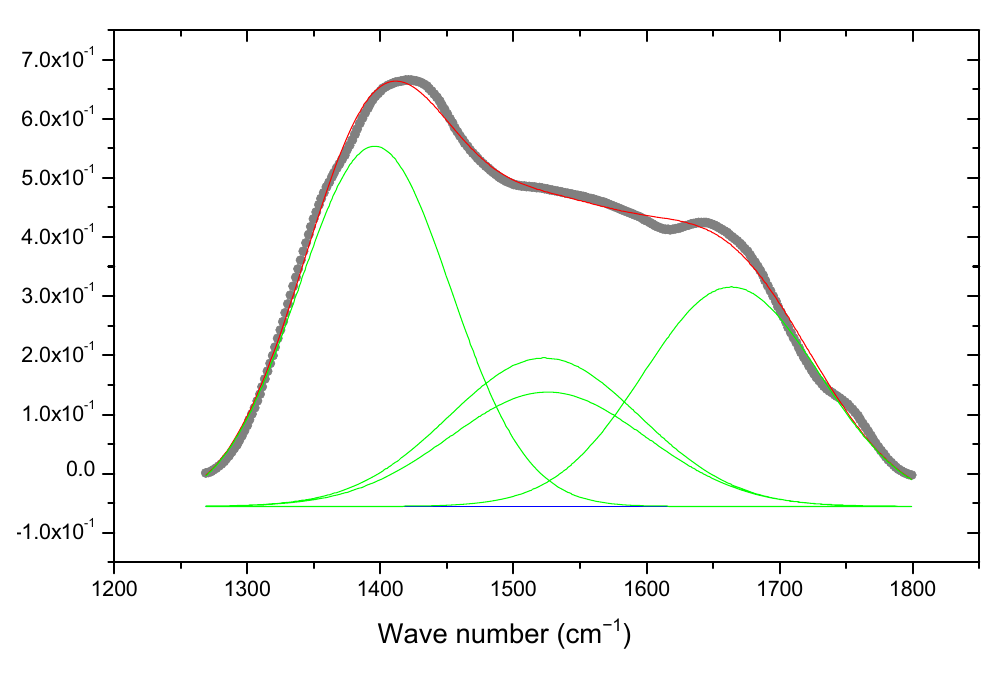
Figure 10. Deconvolution plot of the carbonates zone FT-IR spectra of as-synthezised hydrotalcite.